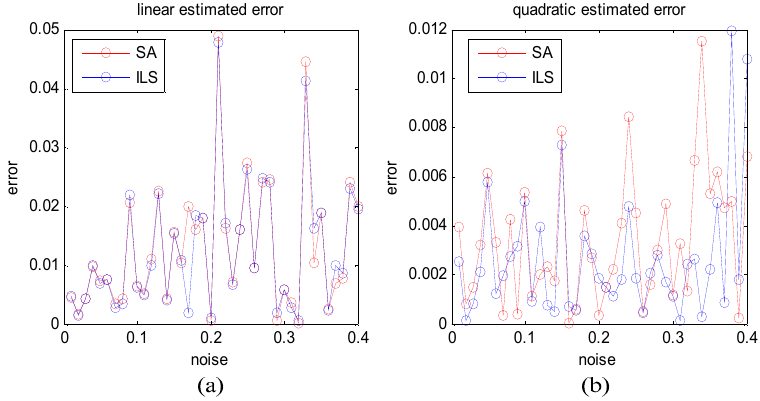
Figure 3. With different Gaussian white noise levels, the linear ( a ) and quadratic ( b ) estimated errors of SA (red) and ILS (blue) algorithm.